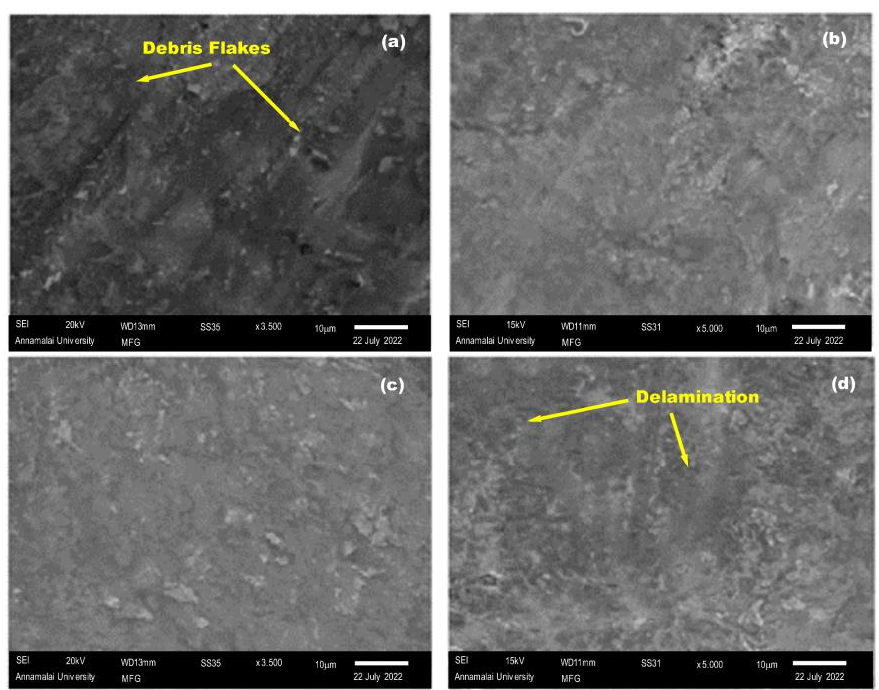
Figure 19. Micrographs showing worn-out surfaces of TiB 2 -30Si 3 N 4 -6B 4 N at: ( a ) 6 N, ( b ) 12 N, ( c ) 18 N, and ( d ) 24 N.